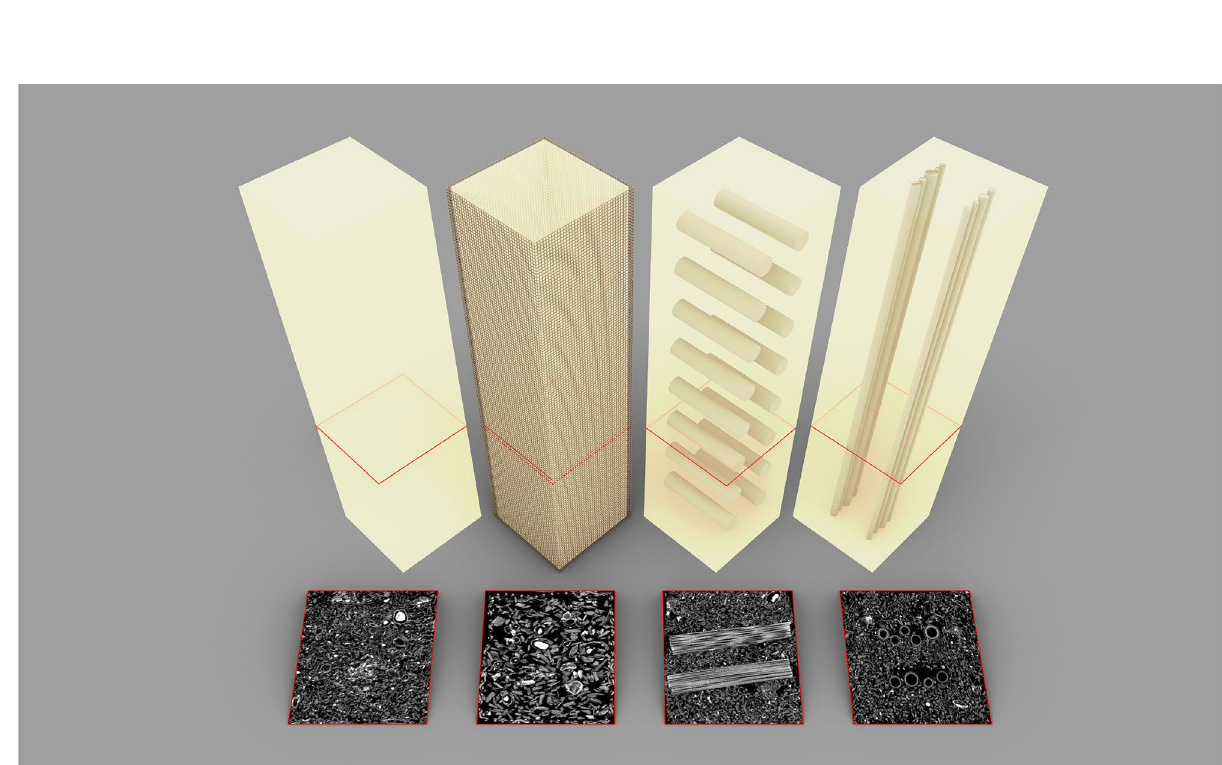
Figure 3. Fibre placement strategies and their sectional CT scan (left to right): control (BS), jacketing coaxial to load (BM_H), fibres perpendicular to load (BS_R), fibres coaxial to load